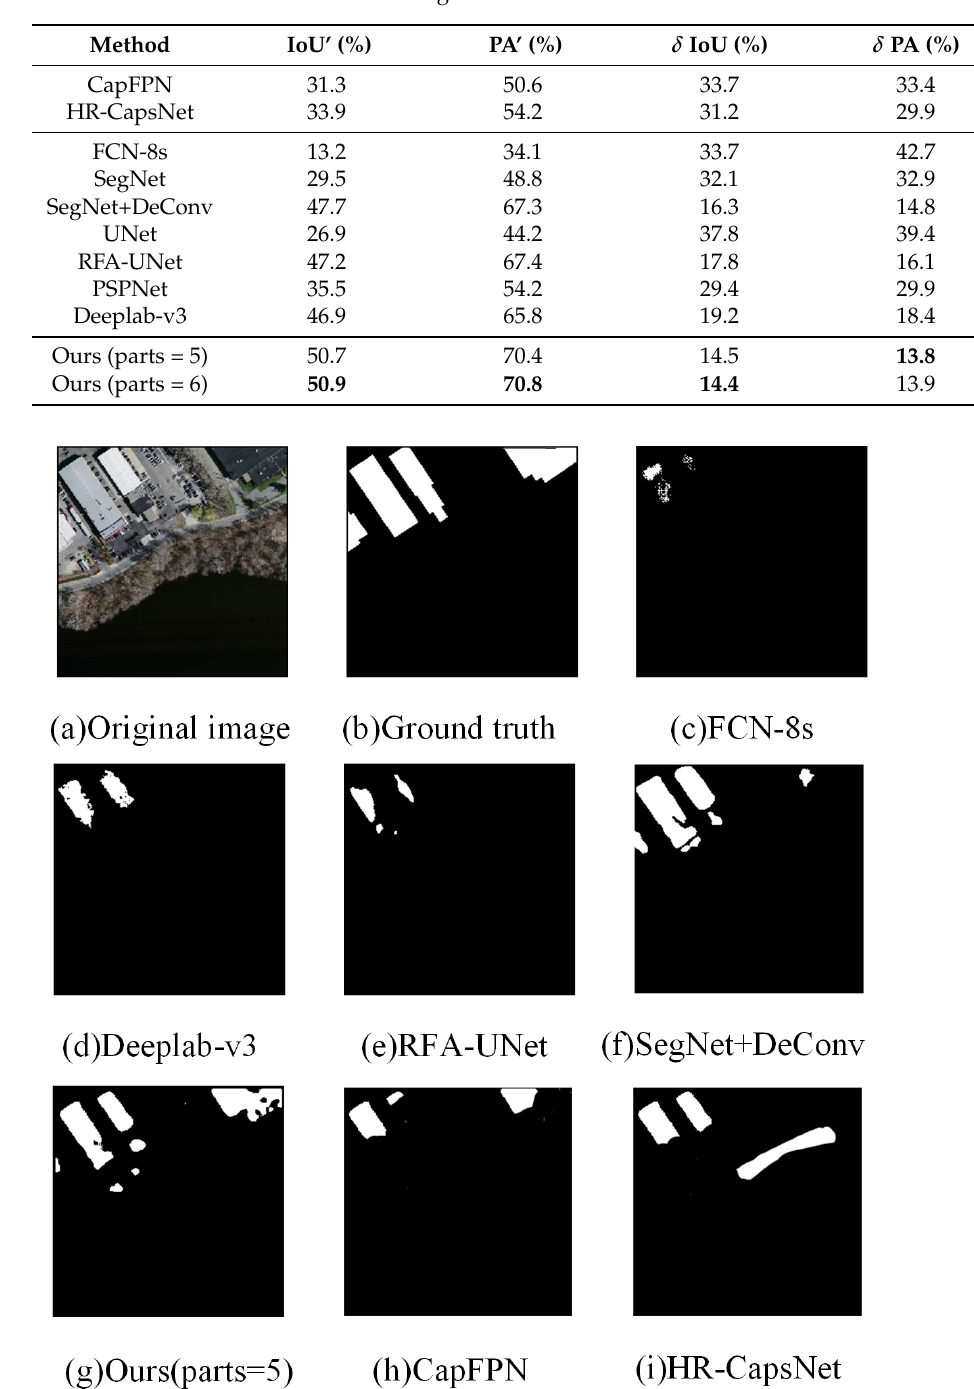
Table 4. Performance of different building extraction methods on the unfamiliar dataset.